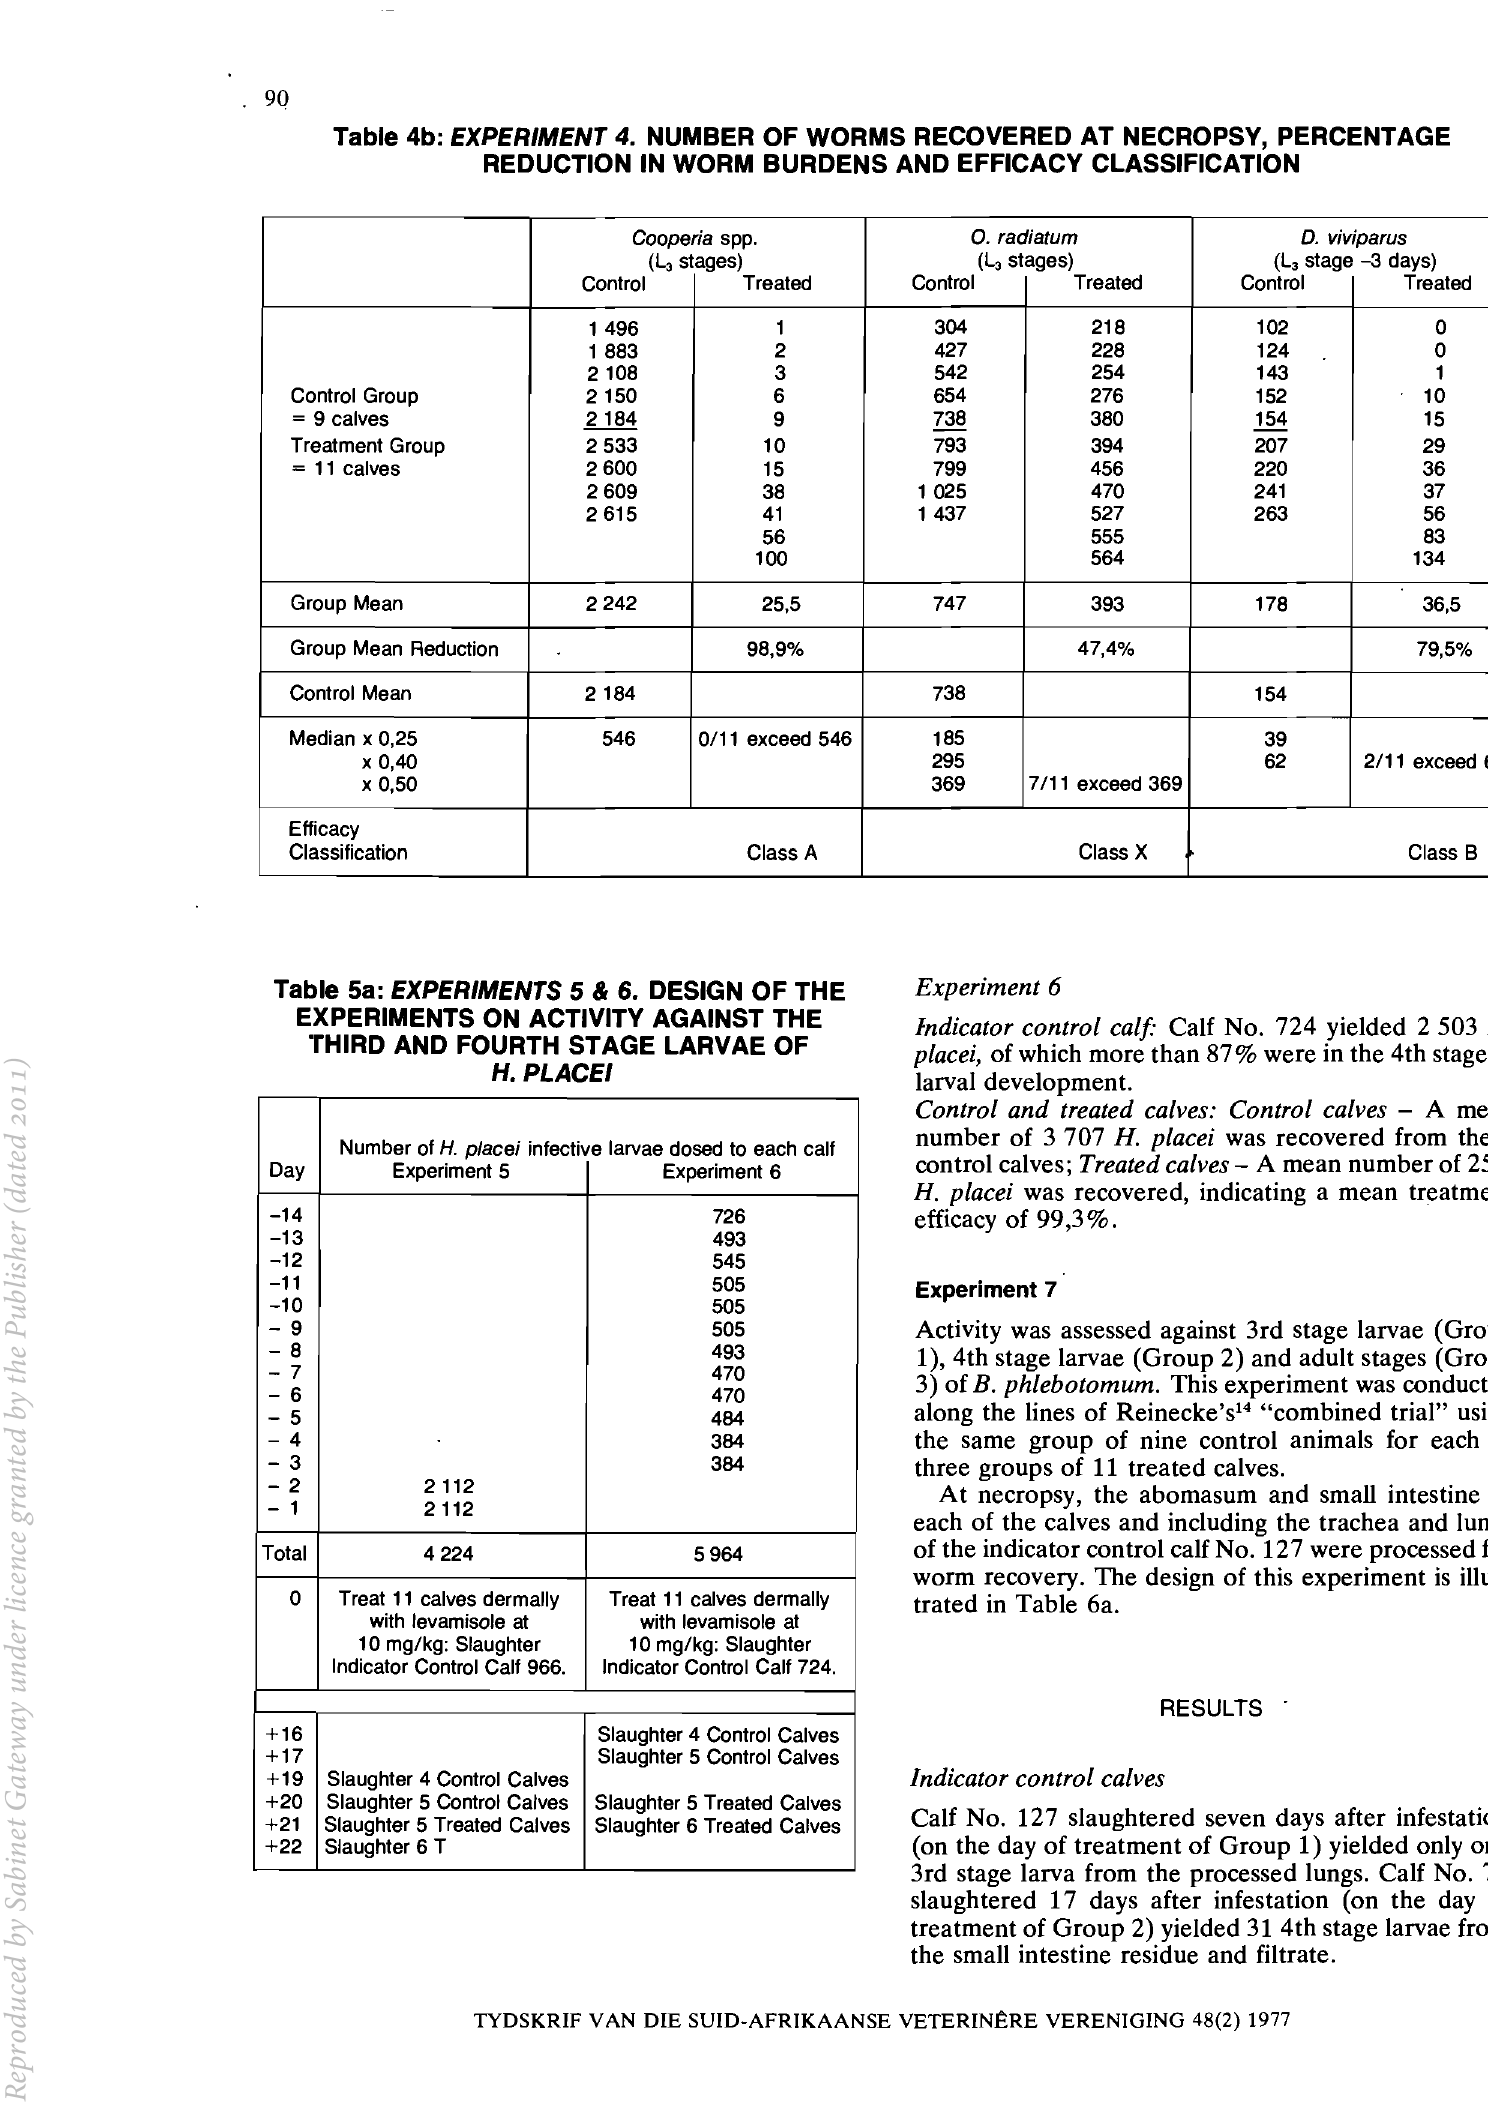
Table 4b: EXPERIMENT 4. NUMBER OF WORMS RECOVERED AT NECROPSY, PERCENTAGE